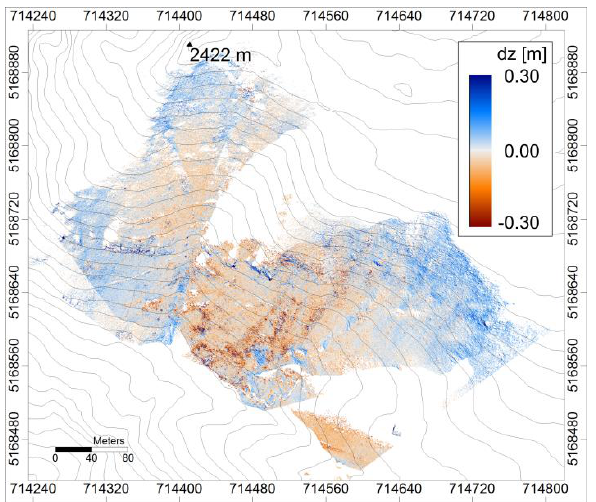
Figure 4. Raster elevation difference between the ULS DSM and the TLS DSM after fine registration; 10-m contours in grey.